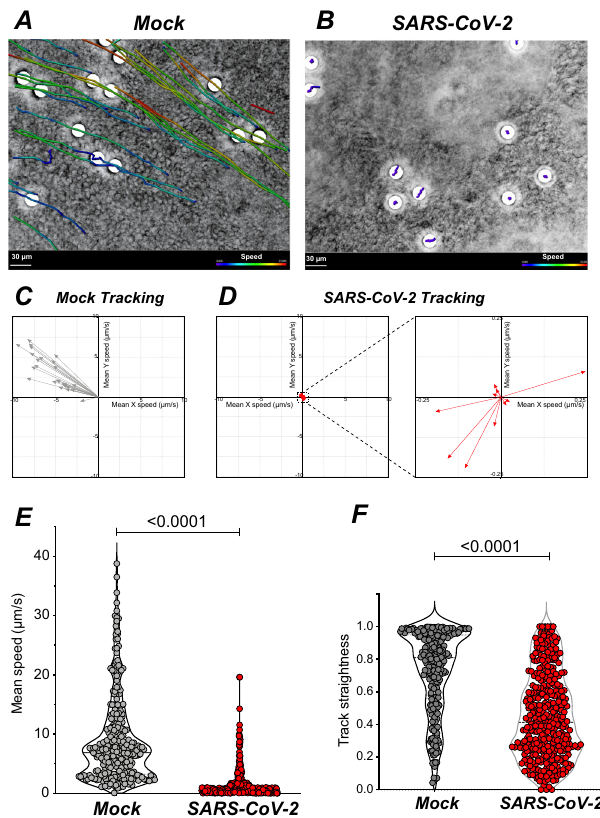
Fig. 5 SARS-CoV-2 infection impairs mucociliary clearance. A, B Representative examples of bead tracking on mock ( A ) and infected ( B ) epithelia at 7 dpi. Bead speed is color-coded in each track. C, D Vector representation of tracks from A and B showing bead speed and direction. A low bead speed is observed in infected epithelia ( D , left), with an enlarged view showing non-uniform directions ( D , right). E, F Bead mean speed ( E ) and track straightness ( F ) measured in mock and infected epithelia at 7 dpi ( n = 3 independent experiments, with 68 – 118 beads tracked per sample; Mann – Whitney